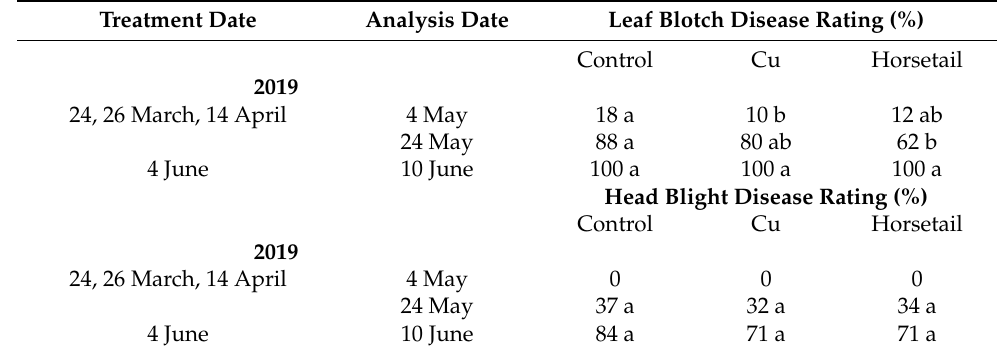
Table 3. Calendar dates for Cu and horsetail macerate treatments and disease ratings for